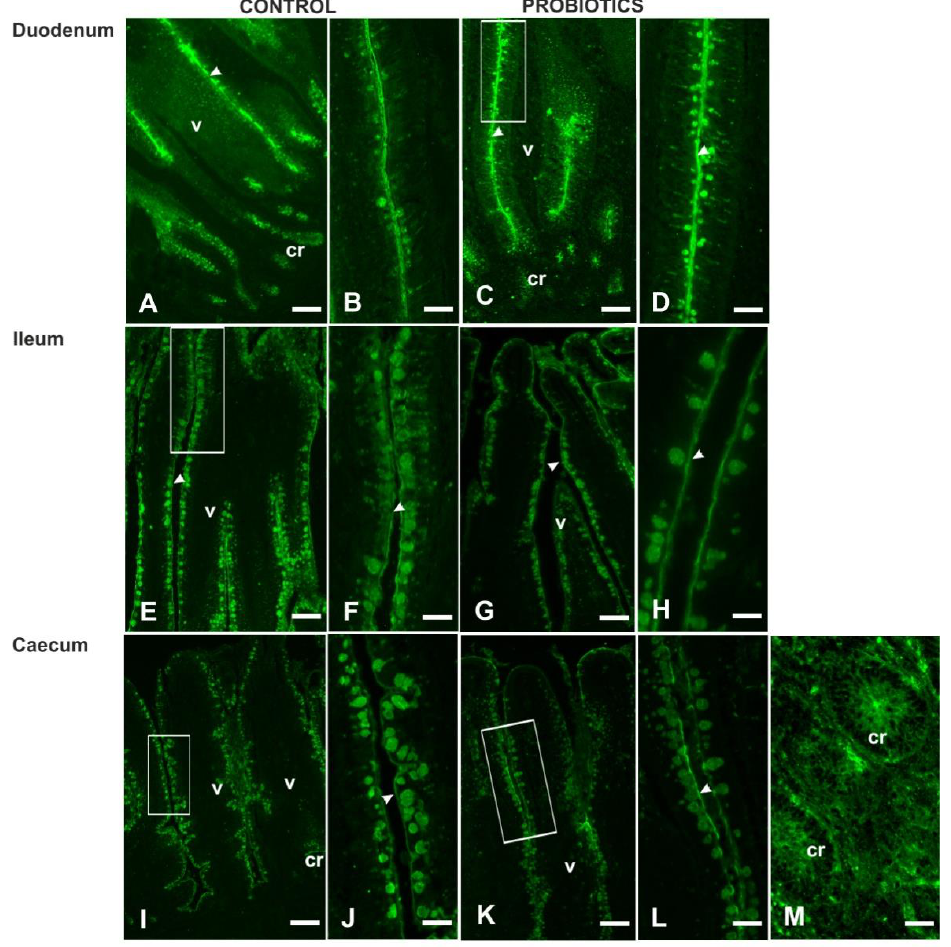
Figure 11. Fucosylated glycans in the intestine of C ( A , B , E , F , I , J ) and P ( C , D , G , H , K , L , M ) guinea fowls showed with LTA. D,F,J,L display high magnification of the rectangle-marked zone from C,E,I,K. cr, crypt; v, villus; arrowhead, luminal surface. Scale bars: A,C,I,K, 100 µm; B,D,J,L, 30 µm; E, 50 µm; F,H, 25 µm; G, 70 µm; M, 120 µm. Ulex europaeus agglutinin (UEA I) evidenced the presence of αl,2-fucosylated glycans